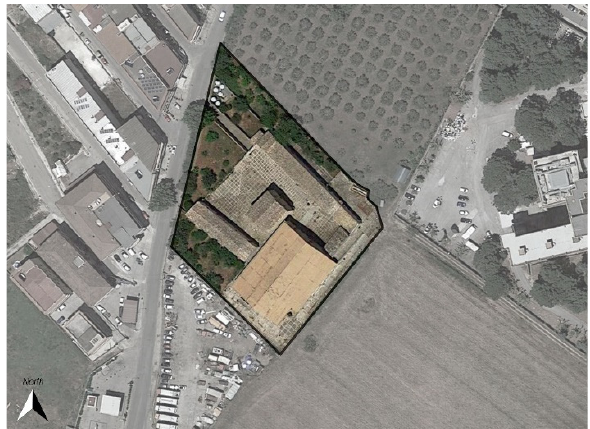
Figure 1 . The “ Real Cantina Borbonica ” and the courtyard.